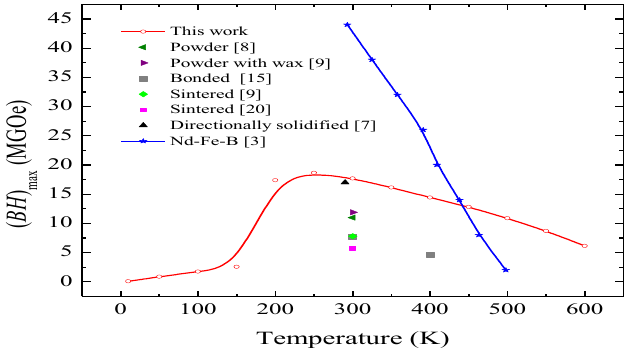
max ( T ) for Nd-Fe-B. max